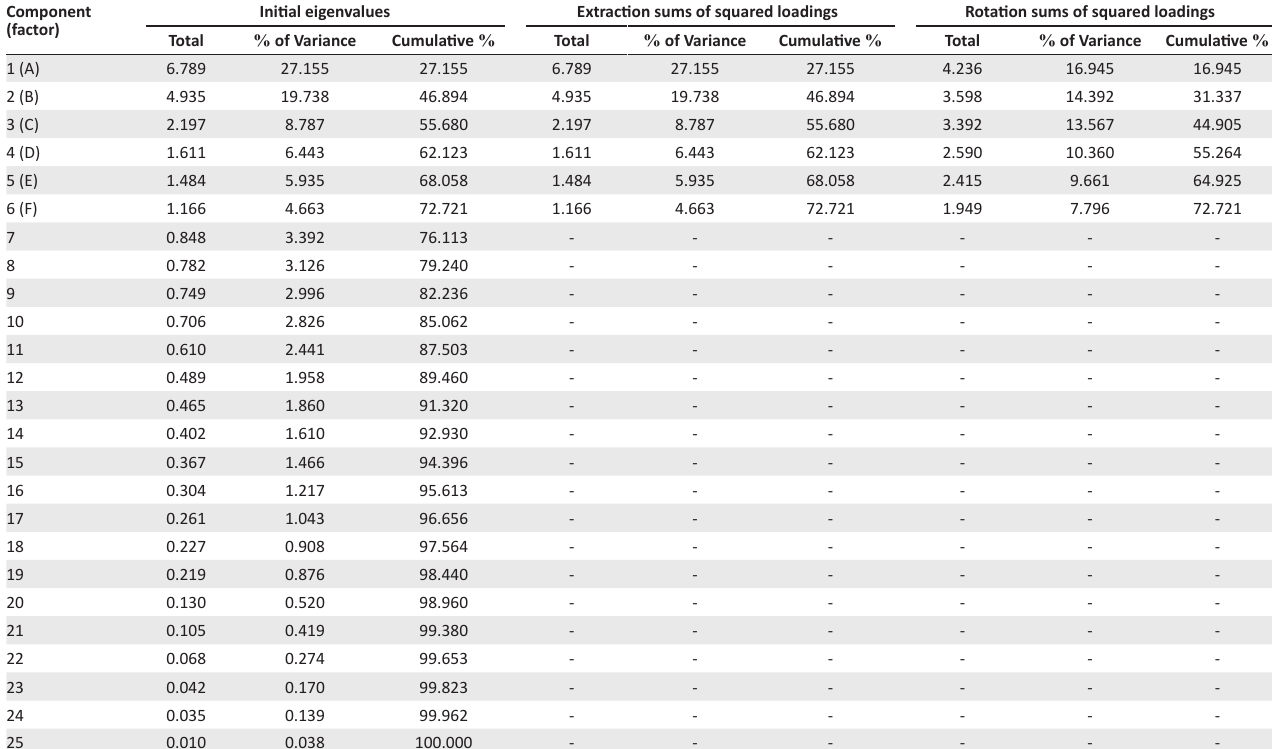
Initial eigenvalues Extraction sums of squared